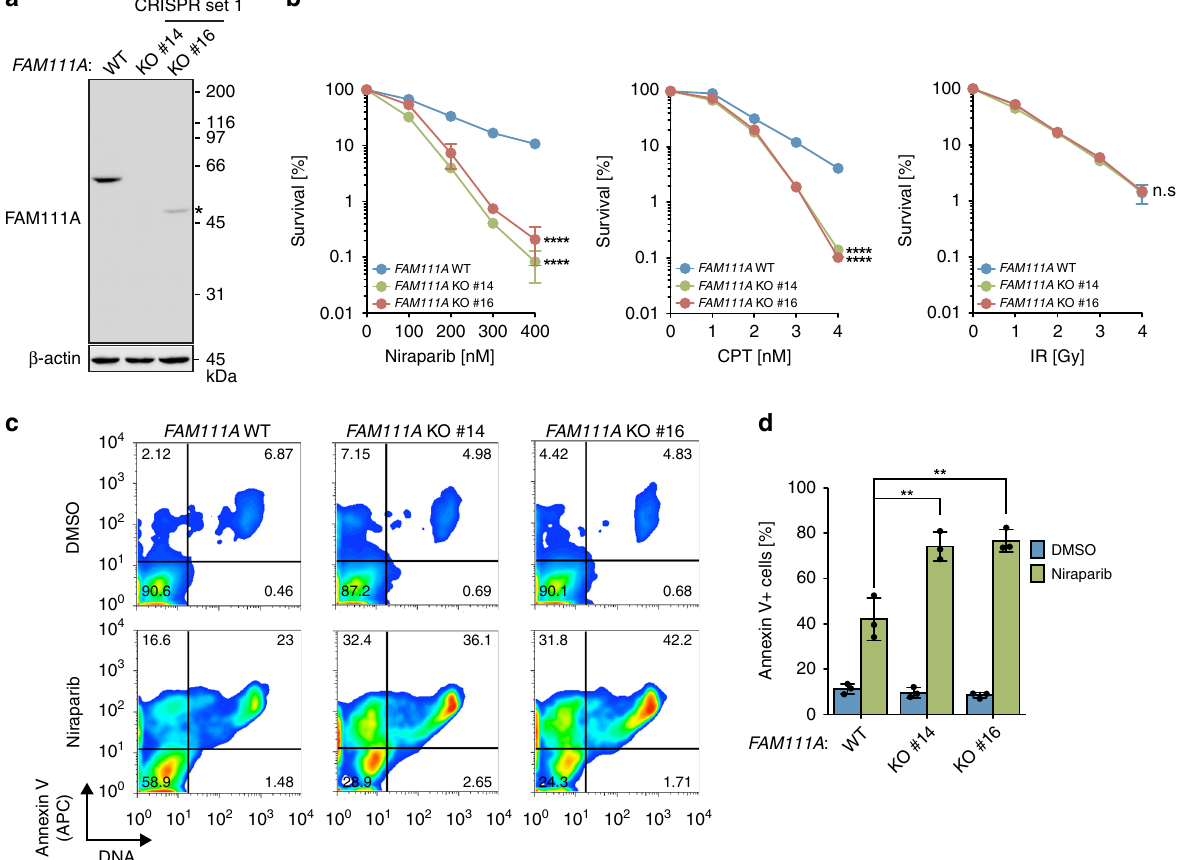
Fig. 1 FAM111A de fi ciency sensitizes cells to PARPis and CPT. a Knockout of FAM111A by CRISPR/Cas9 (set 1 gRNA). Parental HAP1 (WT) and FAM111A KO clones (KO #14 and #16) were analyzed for the indicated proteins by Western blotting. *, truncated FAM111A protein. b Clonogenic survival assays. Cells analyzed in a were cultured in the presence of the indicated concentration of niraparib or CPT for 6 days. For ionizing radiation (IR), cells were irradiated at the indicated doses and cultured for 6 days. Results shown are representative of three independent experiments and values are mean ± s.d. of technical replicates ( n = 3). p values were calculated relative to FAM111A WT. **** p < 0.0001; n.s. not signi fi cant (two-tailed unpaired t -test). c Analyses of cell death by Annexin V/PI staining. After treatment with 1 µ M niraparib or DMSO for 48 h, cells stained with Annexin V-APC and PI were analyzed by fl ow cytometry. Results shown are representative of three independent experiments and percentages of cells in each quadrant are indicated. d Quanti fi cation of Annexin V-positive cells. Experiments were performed as in c . Values are mean ± s.d. of independent experiments ( n = 3). ** p < 0.01 (two-tailed unpaired t -test). Source data are provided as a Source Data fi